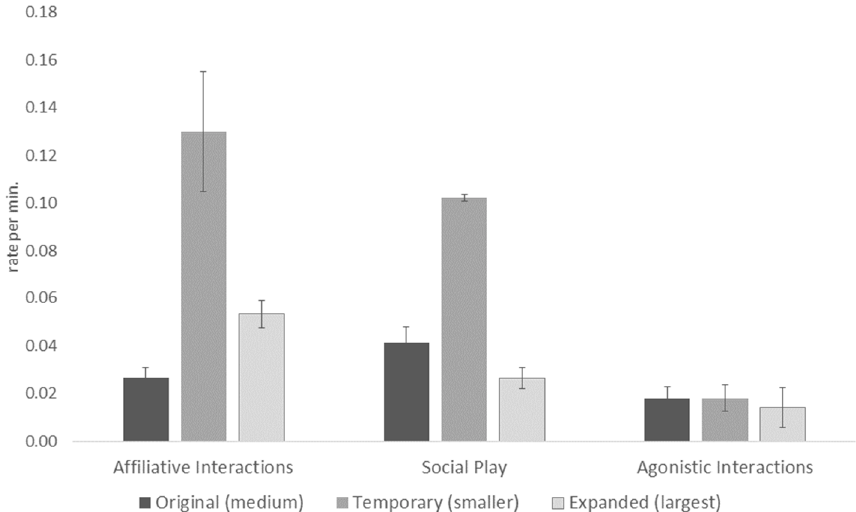
Figure 1. Mean rates per minute ± SE of social interactions for n = 3 male grizzly bears when they occupied three different-sized habitats.